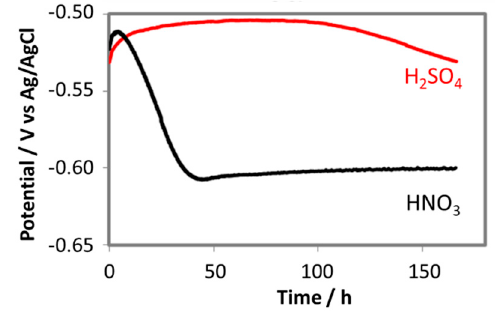
Figure 12. The change in free corrosion potentials of L360NB exposed to CO 2 saturated 0.114 M H 2 SO 4 and 0.0184 M HNO 3 contained condensates.